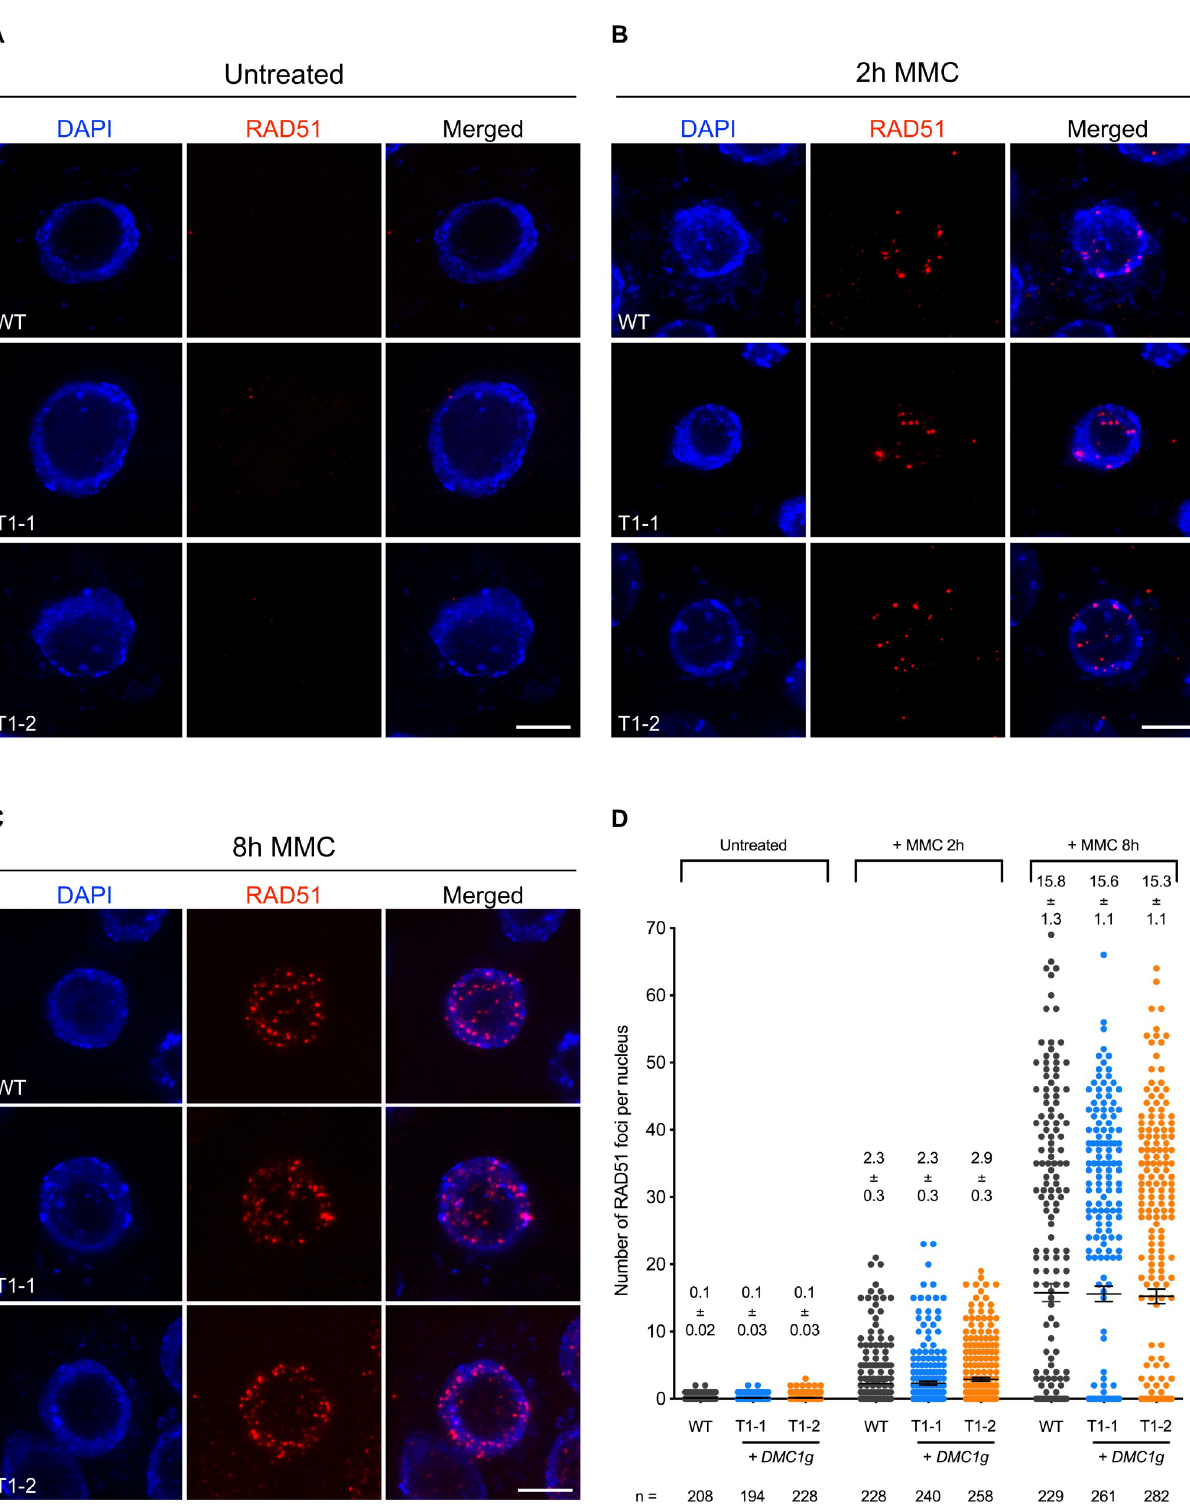
Fig 4. RAD51 foci in somatic cells of DMC1 overexpressing seedlings. (A-C) Immunolocalization of RAD51 in root tip nuclei of wild-type plants expressing pRAD51 :: DMC1g , fixed just before (A) , and 2 (B) or 8 (C) hours after treatment with 30 μ M MMC. T1-1 and T1-2 are two independent transgenic lines expressing pRAD51 :: DMC1g . MMC-induced RAD51 foci are clearly visible in nuclei of the treated plants. DNA is stained with DAPI (blue) and RAD51 foci (detected using an antibody against RAD51) are colored in red. Images are collapsed Z-stack projections of a deconvoluted